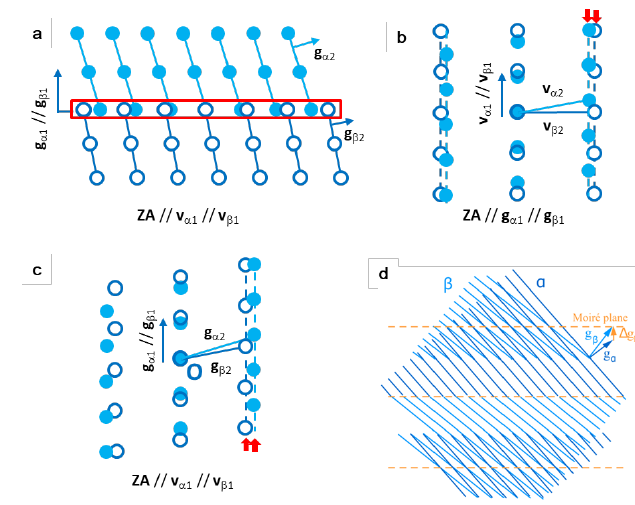
Figure 2. Comparison between near atomic row matching in direct space and reciprocal space. ( a ) Near row matching in the interface viewed along parallel row v α1 // v β1 . ( b ) The atomic matching in the interface containing atomic rows, as indicated in the rectangle in ( a ). ( c ) Simulated diffraction pattern for ( a ). ( d ) The plane edge-to-edge matching at the interface.